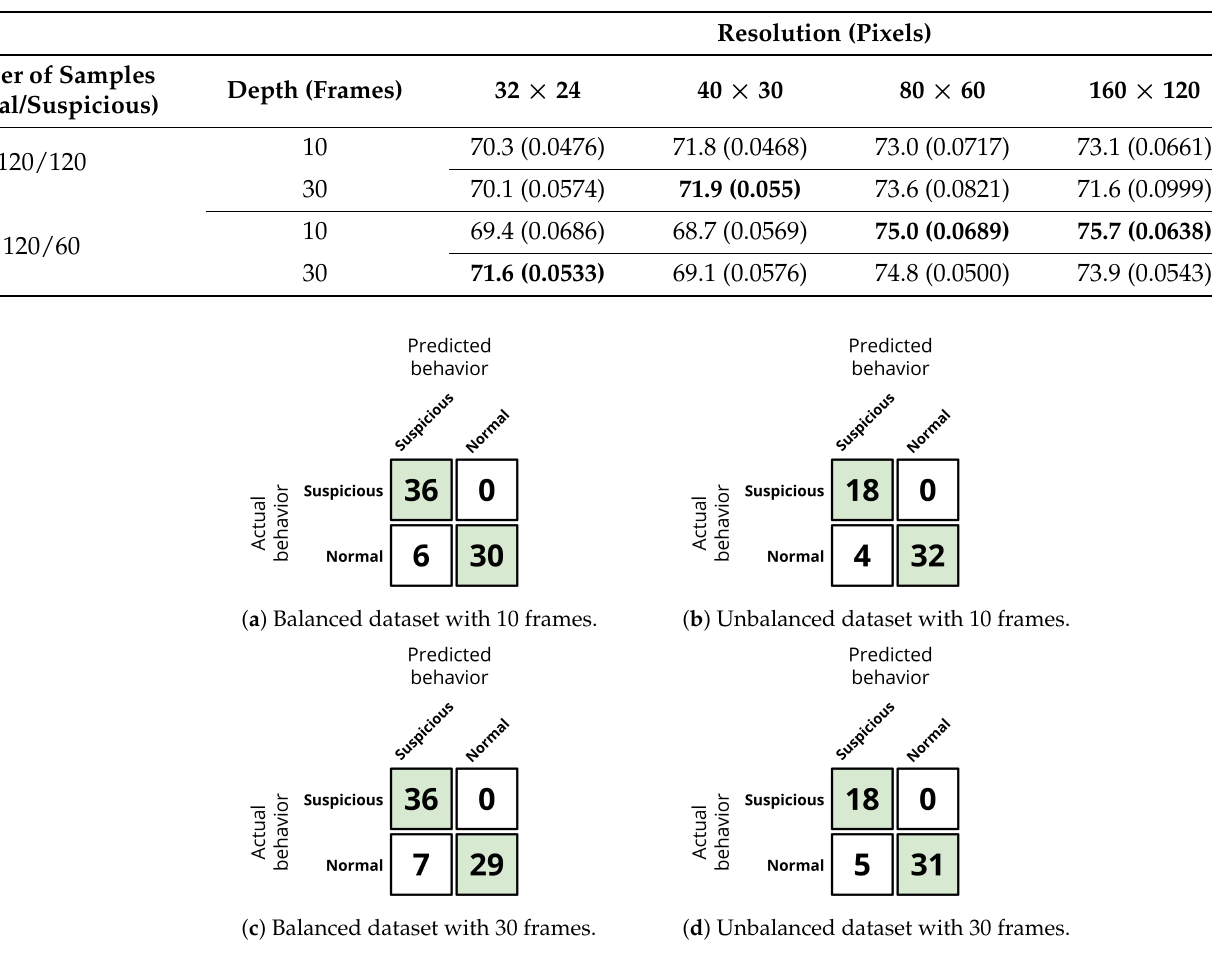
Figure 11. Confusion matrices for the best model generated for each configuration in the confirma- tory